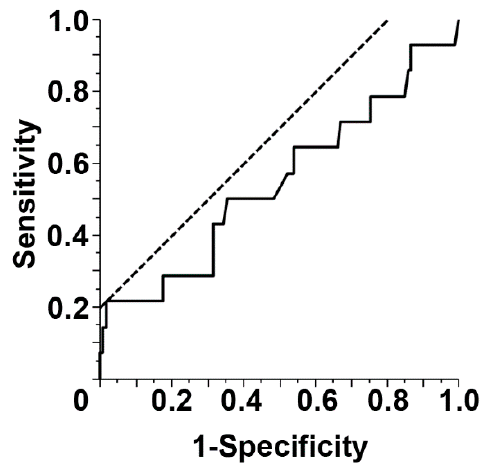
Figure 3. The receiver operating characteristic (ROC) curve for the risk of periprosthetic infection in operating time. The area under the curve (AUC) was 0.54406 (95% CI, − 0.0002–0.0087), and the optimal cut-off value was 493 min.